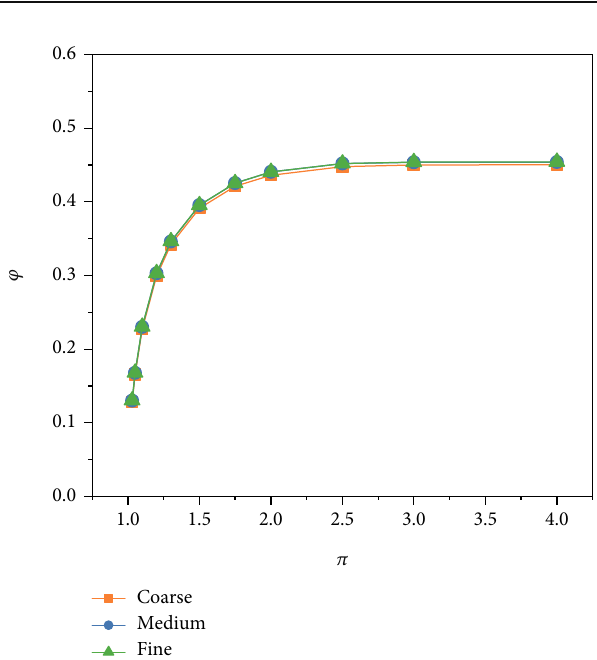
Figure 4: Grid sensitivity